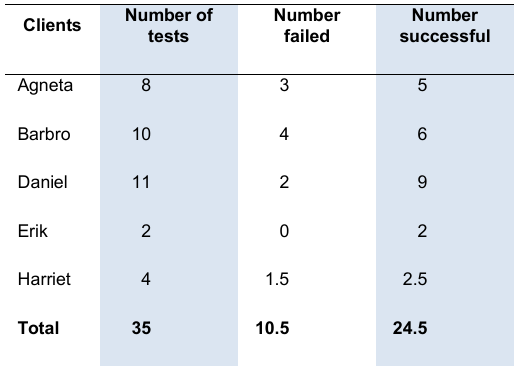
Table 7: The therapist’s response to the “test” he was given in each case of a particular pathogenic expectation of the respective client, the numbers of these “tests” that were successful and the number that failed being